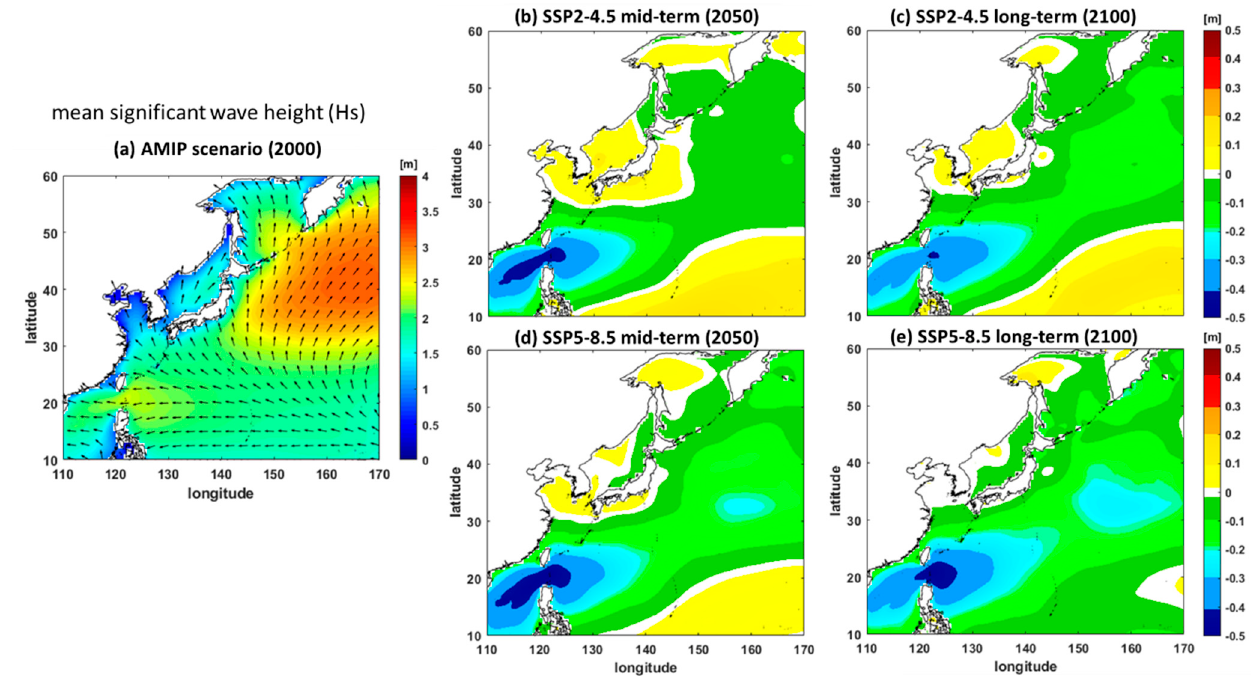
Figure 3. Mean significant wave height (H s in m) results for ( a ) the AMIP scenario result for 2000 and the differences between the results of future scenarios and the AMIP scenario: ( b ) SSP2-4.5 medium-term, ( c ) SSP2-4.5 long-term, ( d ) SSP5-8.5 medium-term, and ( e ) SSP5-8.5 long-term scenarios.